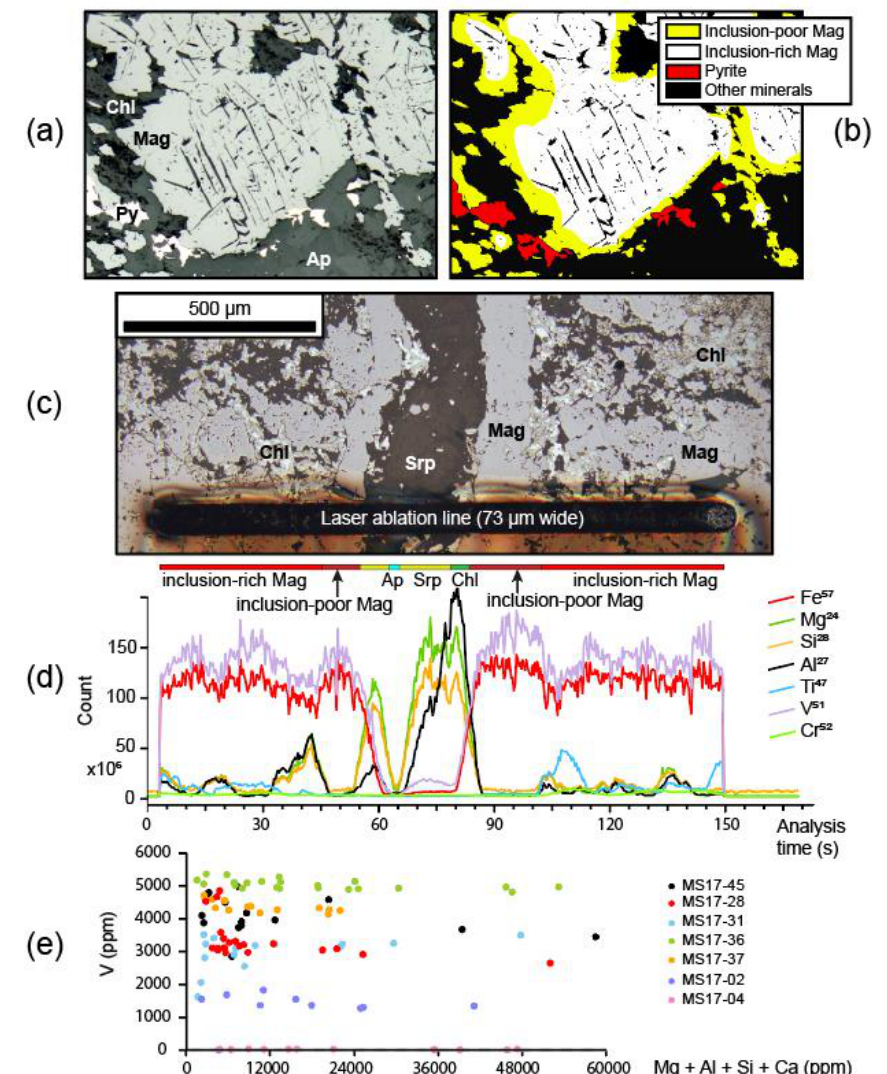
Figure 6. ( a ) Reflected light image and ( b ) assisted mineral recognition (using the GIMP software) performed on sample MS17-31. ( c ) Reflected light image and ( d ) time-resolved profiles showing the distribution of 57 Fe, 24 Mg, 28 Si, 27 Al, 47 Ti, 51 V, and 52 Cr in the minerals of sample MS17-37. Mineral abbreviations are as reported in the literature [34]. ( e ) Magnetite analyzed by LA-ICP-MS (n = 114) displayed on a binary diagram. The sum (Mg + Al + Si + Ca) is a proxy for exsolutions and inclusions: in the inclusion-poor magnetite, the sum of these elements is less than a few hundred ppm. Note that V concentration is uncorrelated to inclusion abundance.